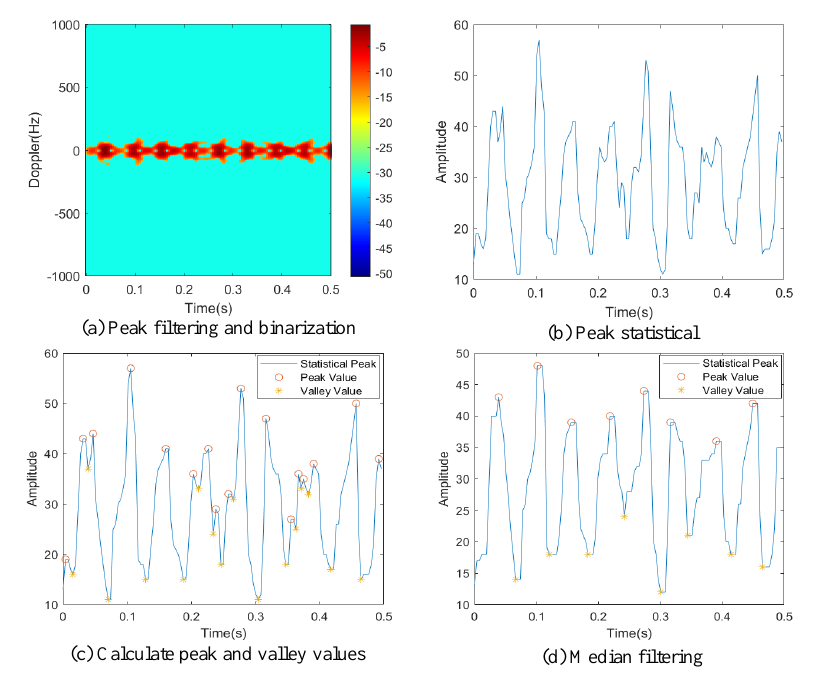
Figure 14. The process of period